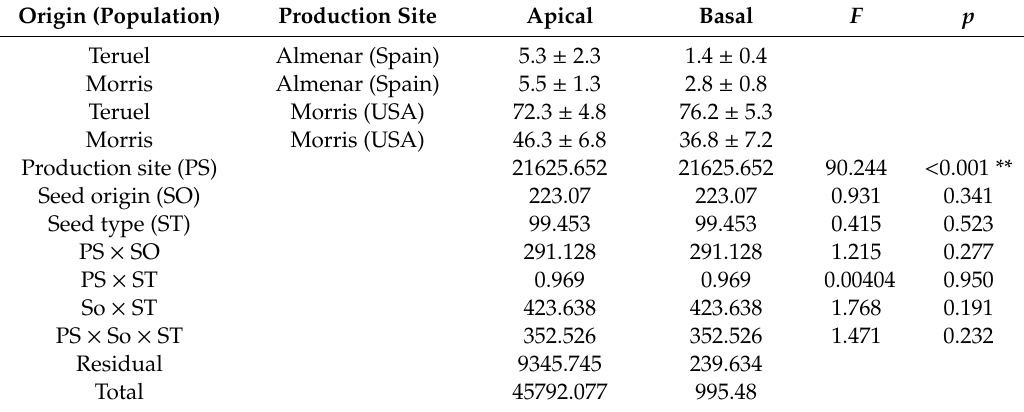
Table 2. Average germination percentages ( ± standard error) for each type of seed produced by each T. arvense population at each site that was produced. Residuals, F of Fisher, and probability ( p ) resulted from the three-way ANOVA are also provided. **, significant di ff erences ( p <